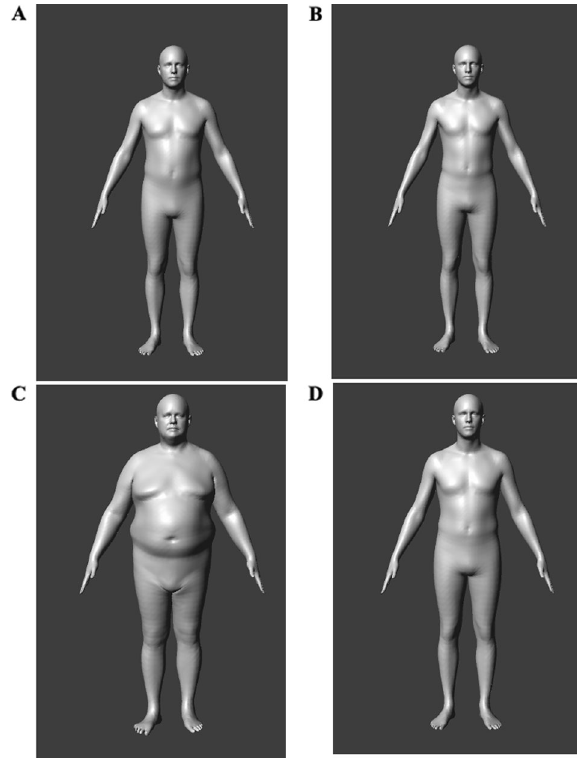
Fig. 4 Stimuli for experiment 2. A Average male body from the SMPL model. B – D Stereotype bodies generated from the data in Experiment 1 for “ Democrat ” , “ Republican ” , and “ Trustworthy ” ,